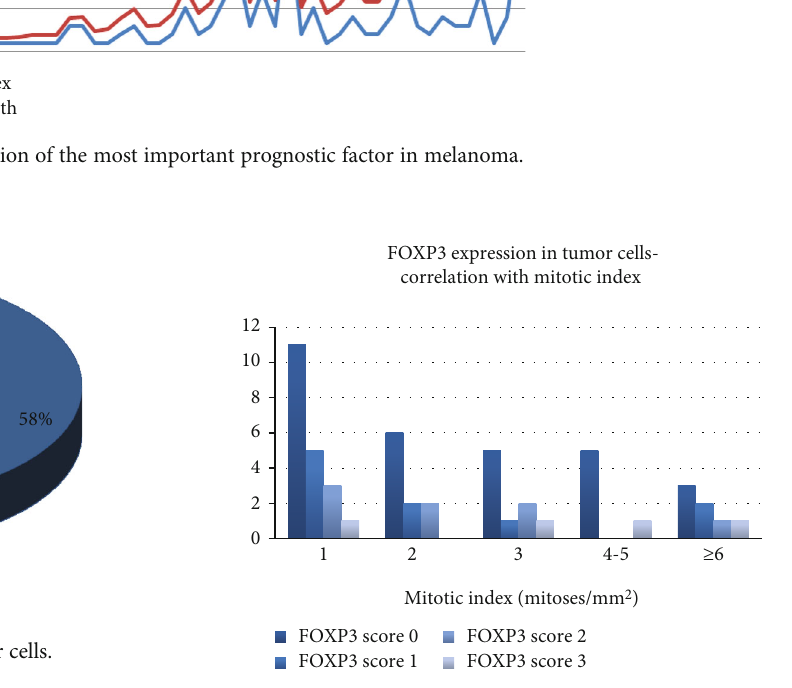
Figure 5: FOXP3 expression within the tumor — correlation with the mitotic